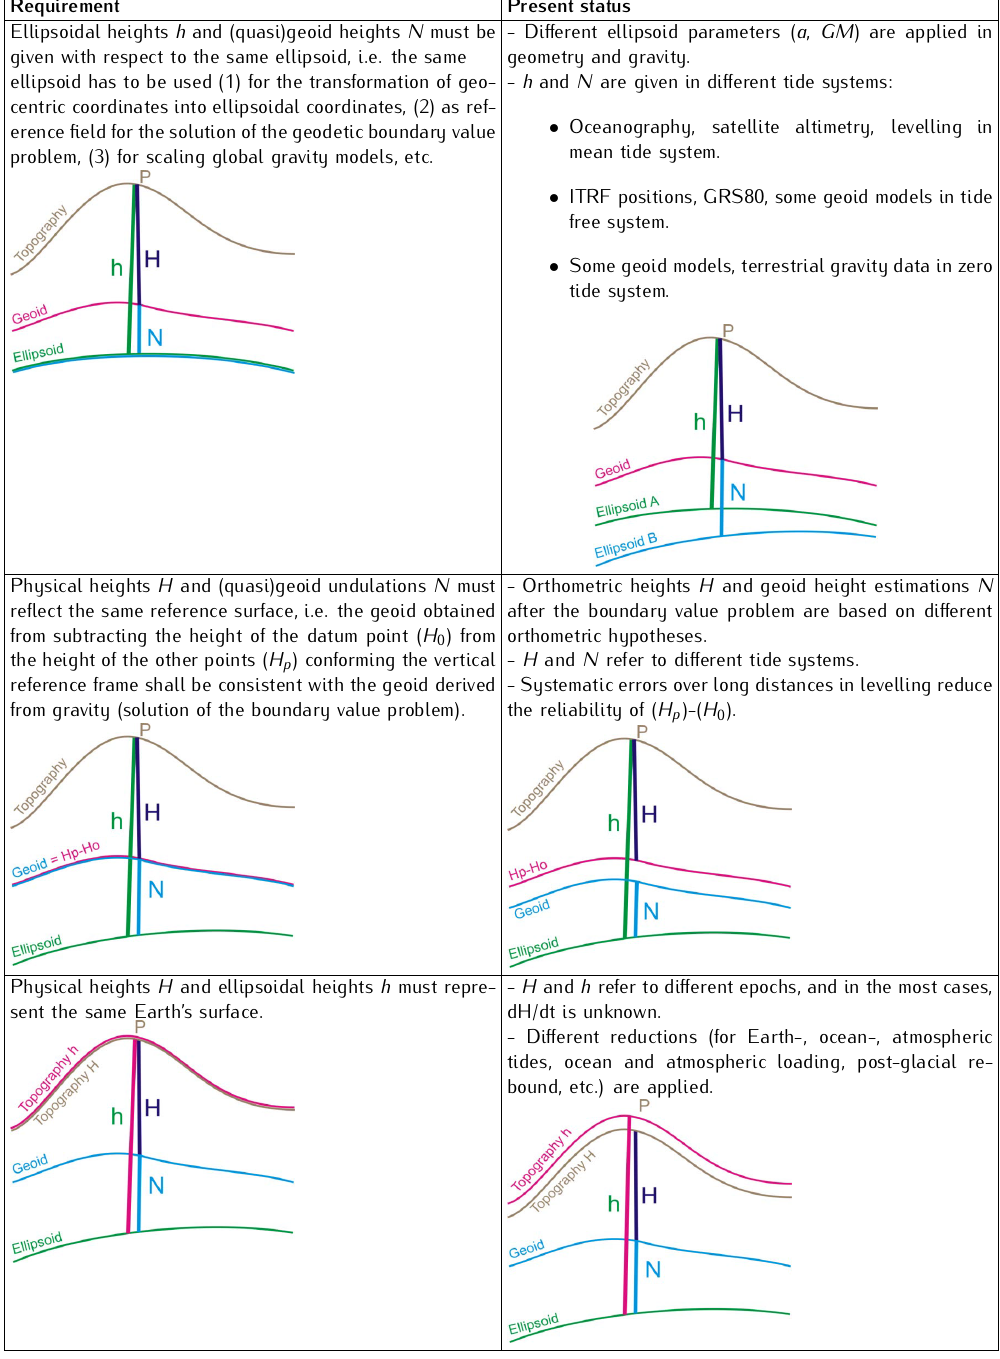
Table 2. Inconsistencies making unsuitable the precise combination of physical and geometric heights. Requirement Present status Ellipsoidal heights h and (quasi)geoid heights N must be given with respect to the same ellipsoid, i.e. the same ellipsoid has to be used (1) for the transformation of geo- centric coordinates into ellipsoidal coordinates, (2) as ref- erence field for the solution of the geodetic boundary value problem, (3) for scaling global gravity models, etc.